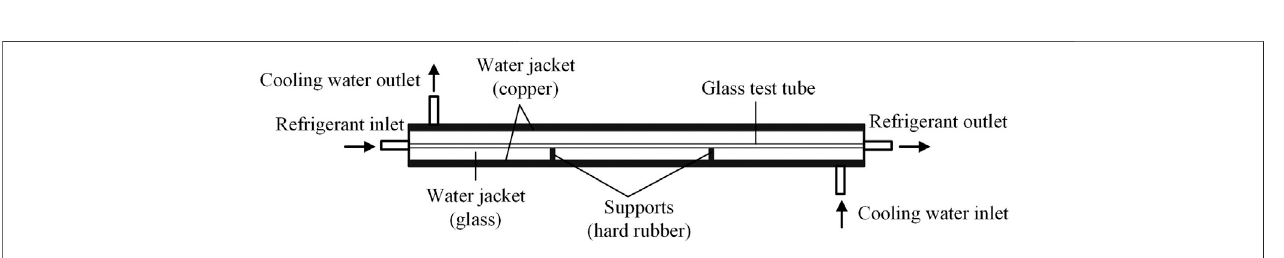
FIGURE 3 | Test section